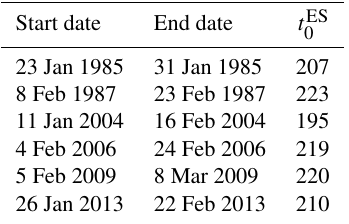
Table 4. Start and end dates of ES events detected by the (cid:49)T 30–70 > 53K